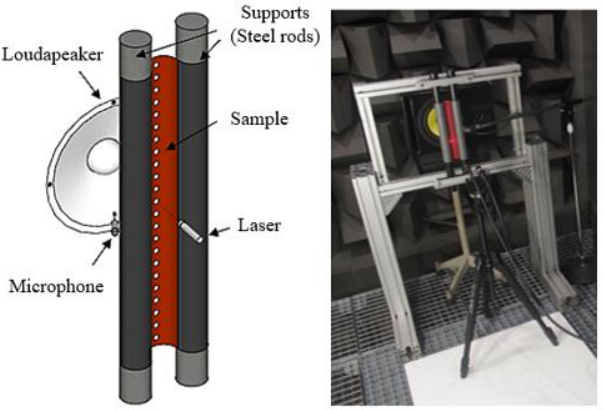
Figure 4. Experimental apparatus for the half-cane sample test detailing the method design and instrumentation.